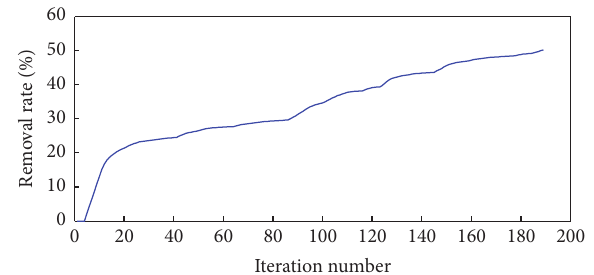
Figure 17: Iteration histories of removal rate.